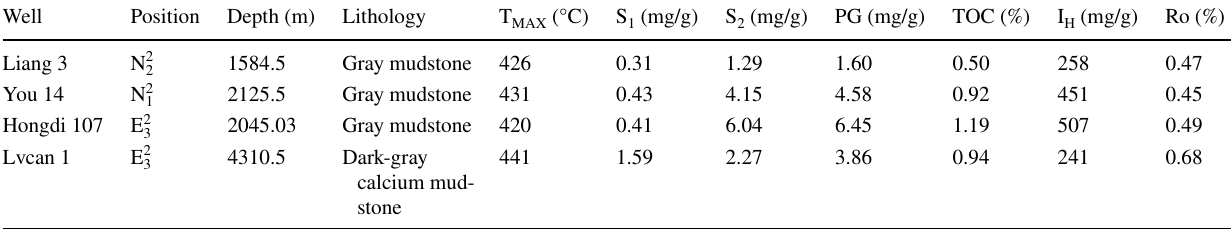
Table 1 Pyrolysis analysis data of Paleogene–Neogene-simulated samples in the Western Qaidam Basin